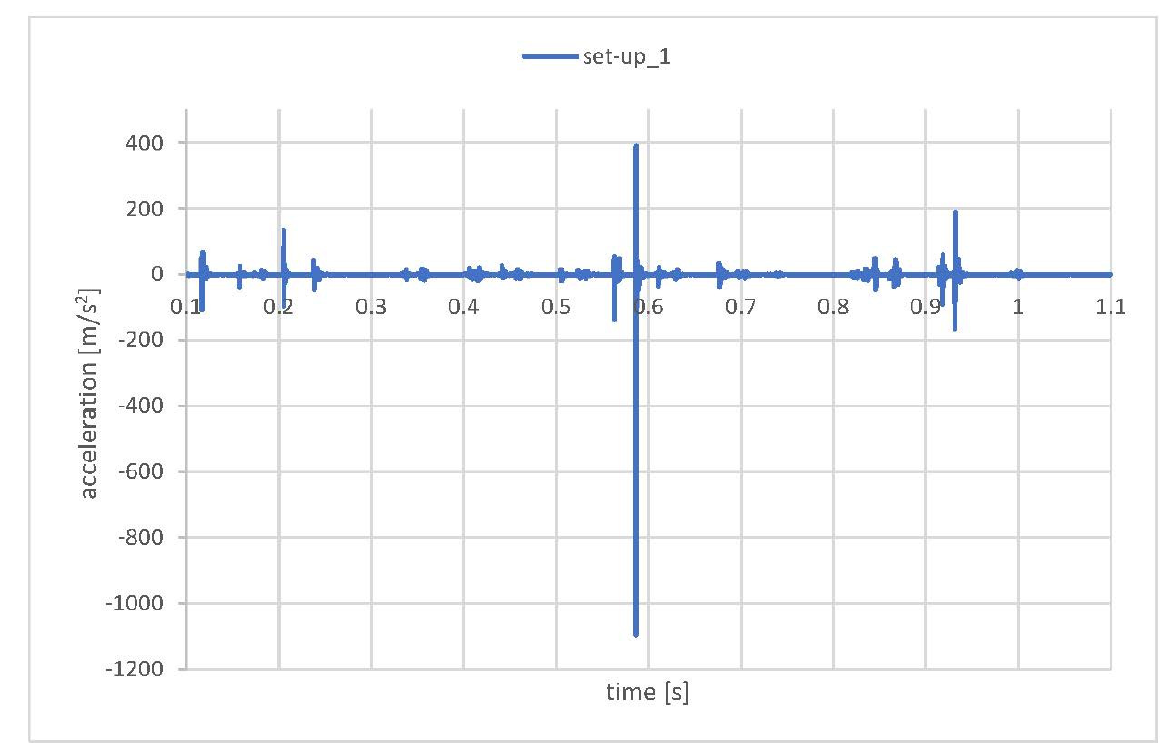
Figure 11. Acceleration trace in one of the initial simulations.